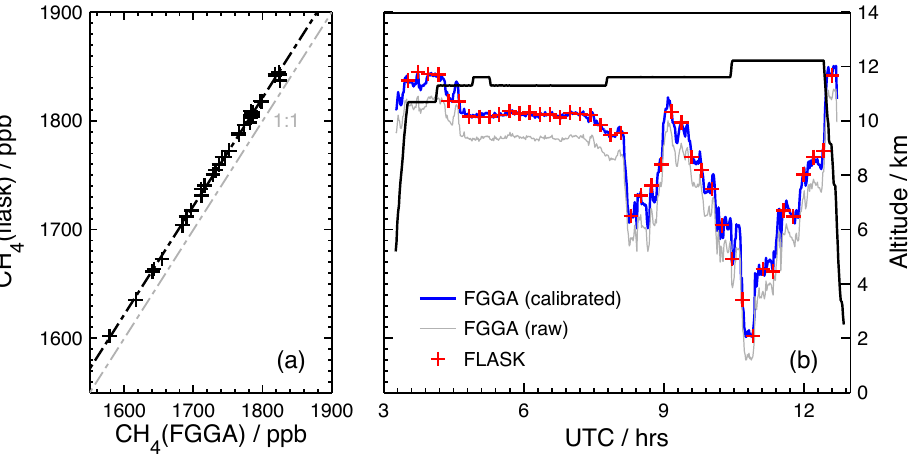
Fig. 6. (a) Depiction of the linear calibration function derived for flight LH336 from Bogota to Frankfurt departing on 23 March 2011. For this flight we find a mean calibration function with a slope 0.9971 and ordinate of 26.46ppb. (b) Calibrated FGGA CH 4 measurements (solid blue trace, 10s averages) and simultaneously obtained flask sample measurements (red + ) on flight LH336. The grey trace depicts the uncalibrated FGGA measurements. The black trace shows the altitude profile for this flight.